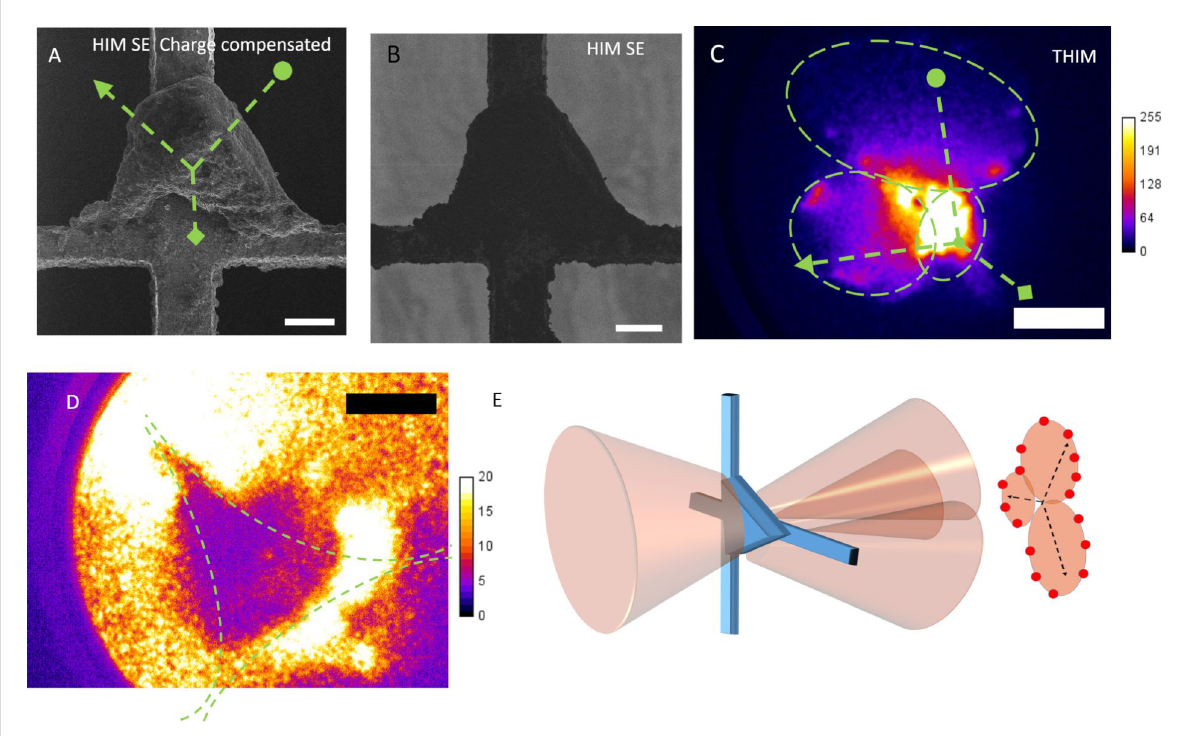
Figure 4: A) HIM SE image with charge compensation by electron flooding and B) HIM SE image without charge compensation. C) THIM deflection from the BN particle showing three regions of intensity outlined with dashed green ovals. D) A THIM deflection pattern with beam focus just behind the sample plane when the deflection areas are spread out. Dashed green lines outline the three separate regions of intensity. E) Schematic illustration of the deflection process. During THIM, He + ions had an energy of 12.5 keV. Scale bars: (A,B) 20 µm and (C,D) 5 mrad. The set of three lines in A and C (with an arrowhead, a circle and a diamond at the ends) are rough guides for the eye showing the relative orientation of the sample and the direc- tions of deflection and expansion (visible in Supporting Information File 1, BN video). The color bar shows the grayscale pixel value recorded in the CCD